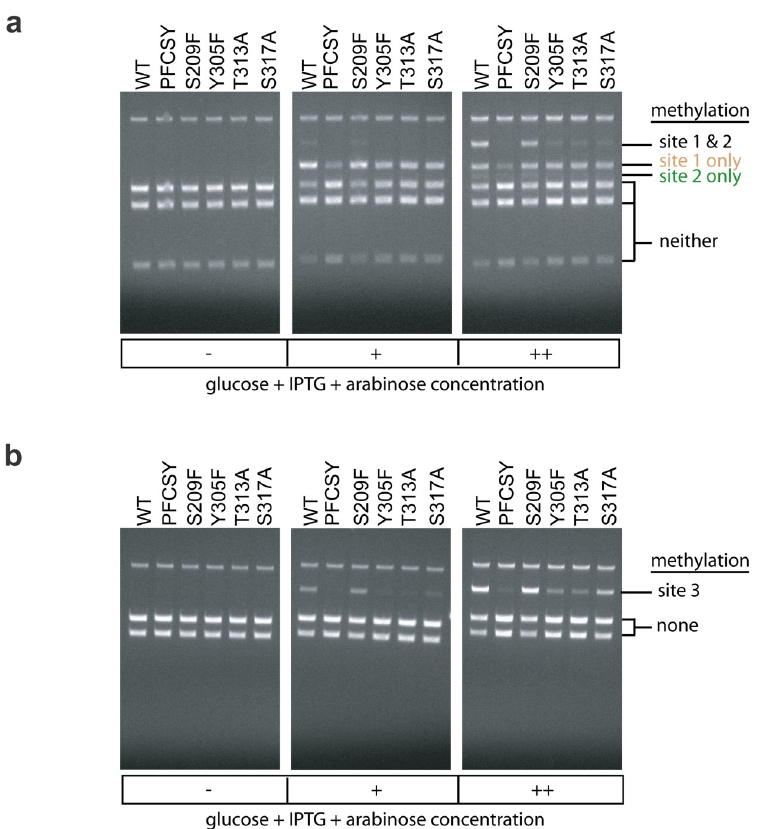
Fig 7. Effect of expression level of dCas9-MC/MN and mutations in MC on methylation activity and specificity. Methylation was assayed by (a) FspI restriction protection assay on sites 1 and 2 and (b) SnaBI restriction protection assay on site 3. sgRNA1 targeted methylation to site 1. Methylation was assayed using isolated plasmid DNA from cells grown in LB media containing (-) 0.2% glucose, (+) 0.2% glucose + 1mM IPTG + 0.0167 arabinose, (++) 0.02% glucose + 1mM IPTG+ 0.0167% arabinose. These supplemented compounds affect the expression of the two fragments of the methyltransferase as explain in Fig 1b and the main text. The symbols (-, +, ++) also qualitatively indicate the expected level of dCas9-MC/MN